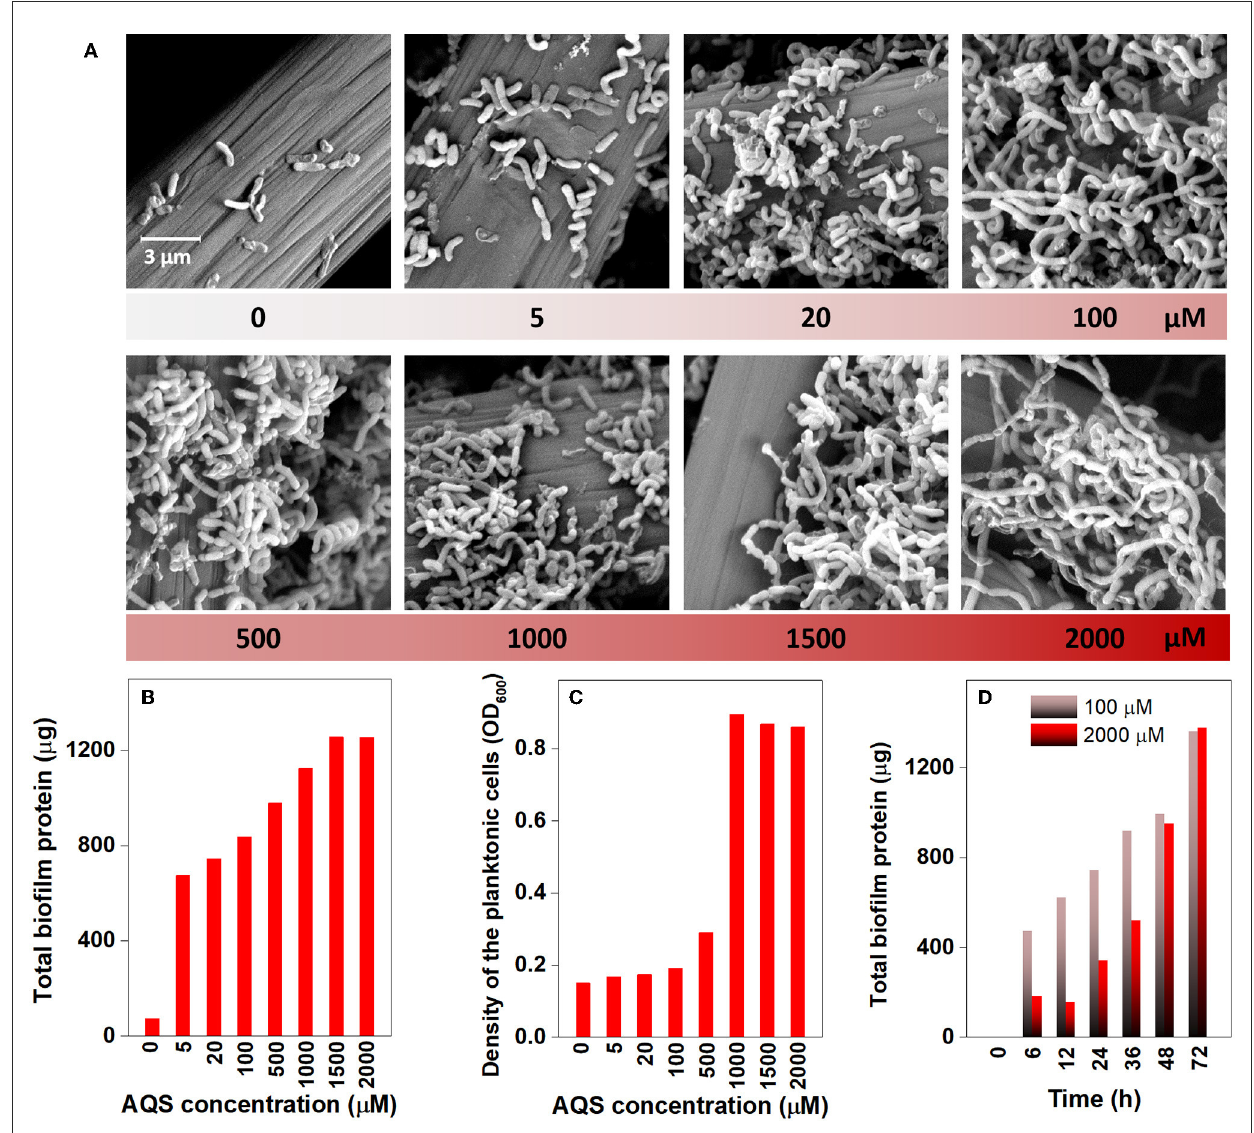
FIGURE2 Scanning electron microscopy images of the biofilm on electrodes (A) , total biofilm protein on electrodes (B) , and cell density in suspension (C) at different concentrations of 9,10-anthraquinone-2-sulfonic acid (AQS) at the end of day 4. (D) Biofilm quantification with time in BESs with 100 and 2,000 µ M